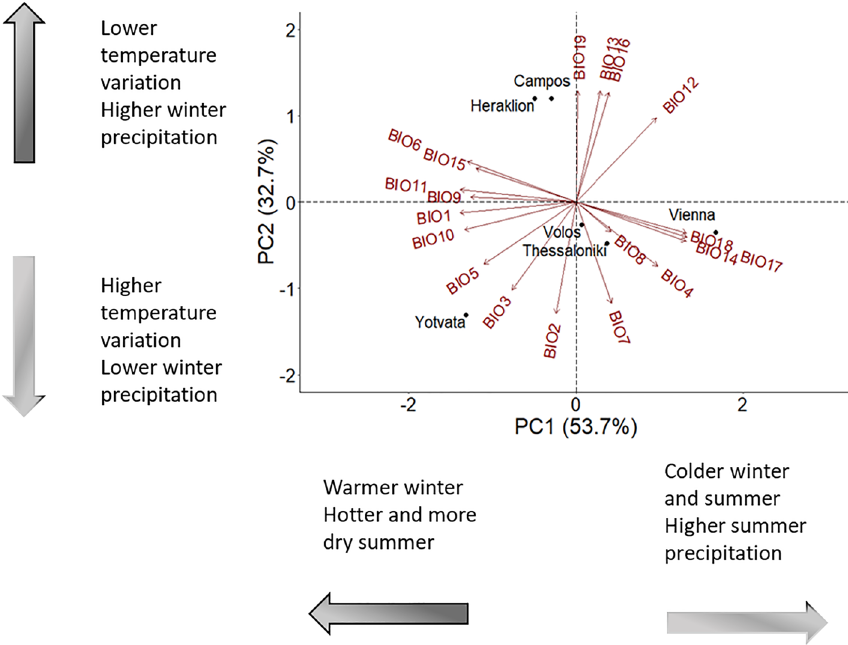
Figure 1. Climatic conditions in the six sampling sites. Principal component analysis (PCA) was performed on 19 variables describing environmental conditions in fly collecting